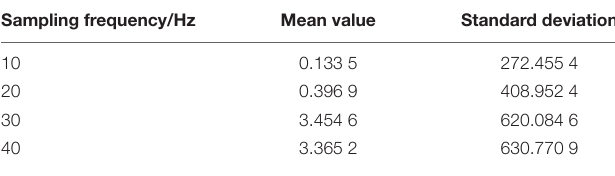
TABLE 3 | Analysis of the Butterworth low-pass filtered